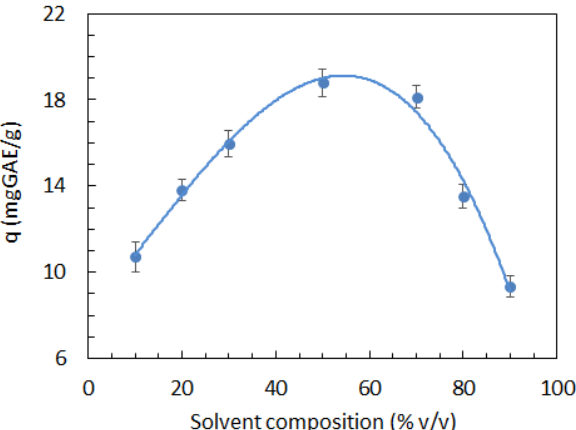
Figure 1. Effect of solvent composition on the amount of extracted phenolic compounds per unit dry weight of SCGs ( q ).